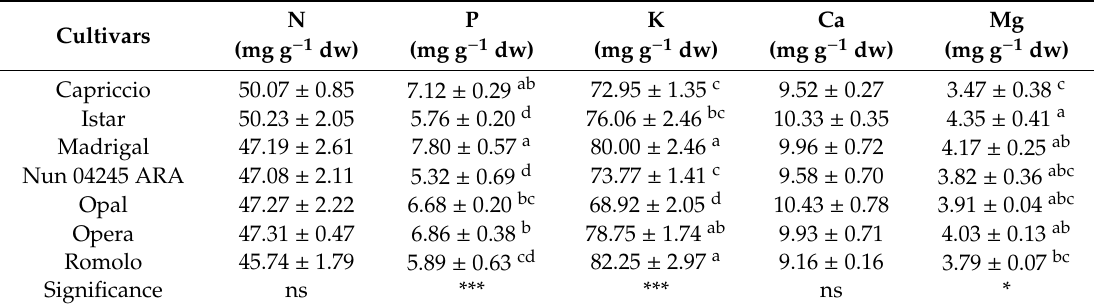
Table 1. Total nitrogen (N), phosphorus (P), potassium (K), calcium (Ca) and magnesium (Mg) concentrations of seven artichoke cultivars grown in a floating raft culture. For each mineral element, di ff erent letters indicate significant di ff erences ( p ≤ 0.05) according to Duncan’s multiple-range test.